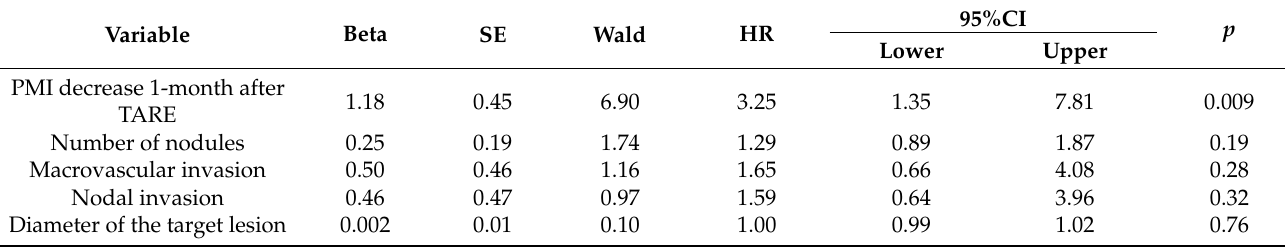
Table 2. Risk factors for progressive disease.